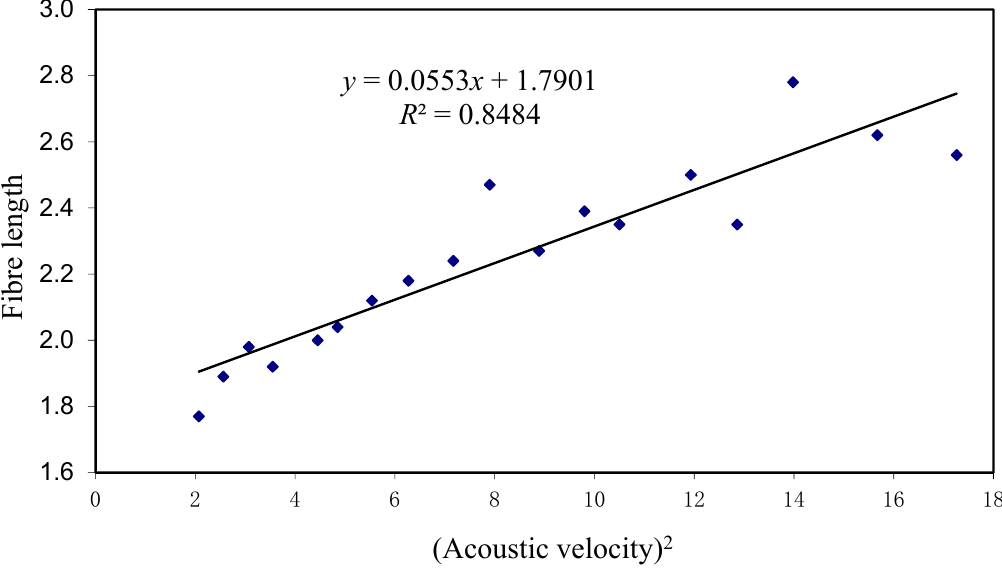
Figure 3. Mean weighted fibre-length (mm) found in 250 peeler cores—from butt logs— first sorted into 18 acoustic velocity groups (km 2 /s 2 ) before being pulped